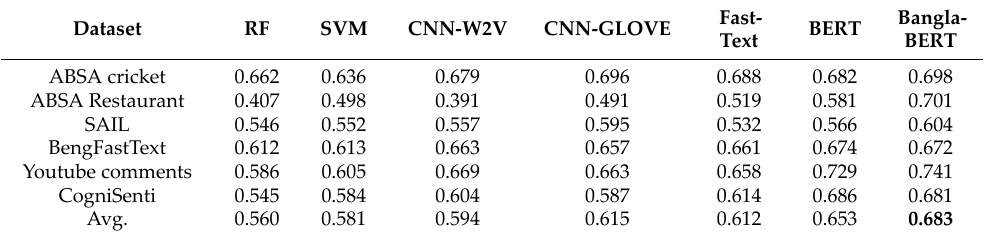
Table 8. Classification results using RF, SVM, CNN, FastText, BERT, and Bangla-BERT.